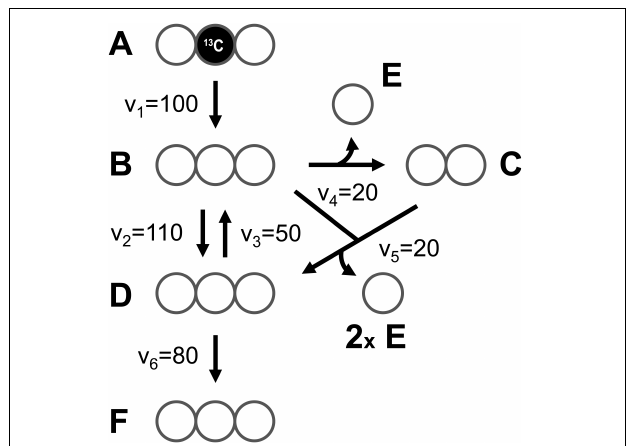
FIGURE 5 | A simple example network model (taken from the original EMU paper), used here to illustrate simulation of tandem MS data using the EMU approach.